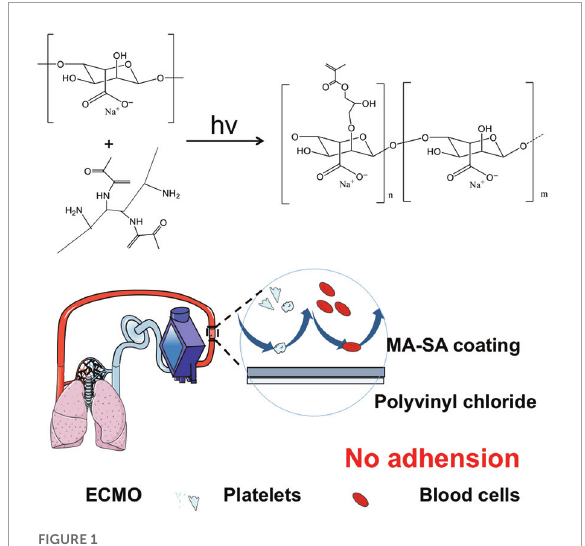
FIGURE1 Methacrylated alginate (MA-SA)-based hydrogel coatings on extracorporeal membrane oxygenation (ECMO) surfaces. The medical device used in this study is polyvinyl chloride (PVC) tubing with MA-SA hydrogel-coated ECMO